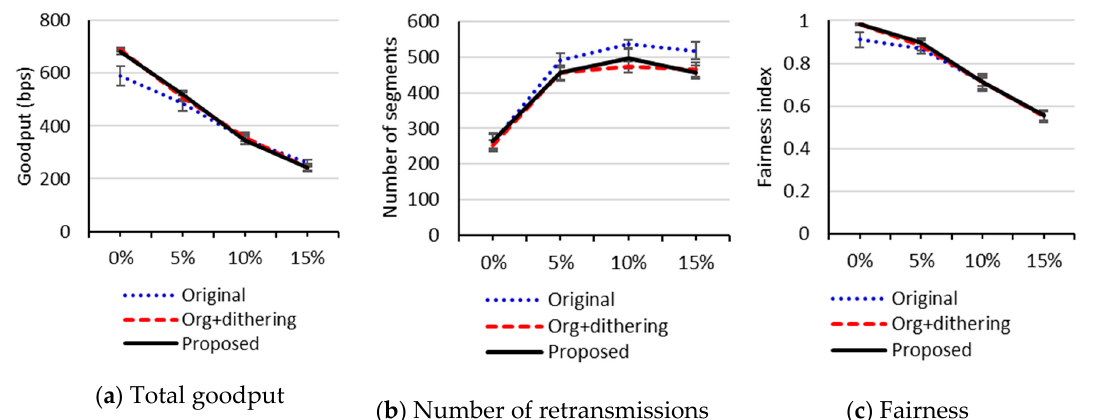
Figure 7. Performance with respect to random loss rates in a 4 × 4 grid topology network when an RDC mechanism is not enabled.